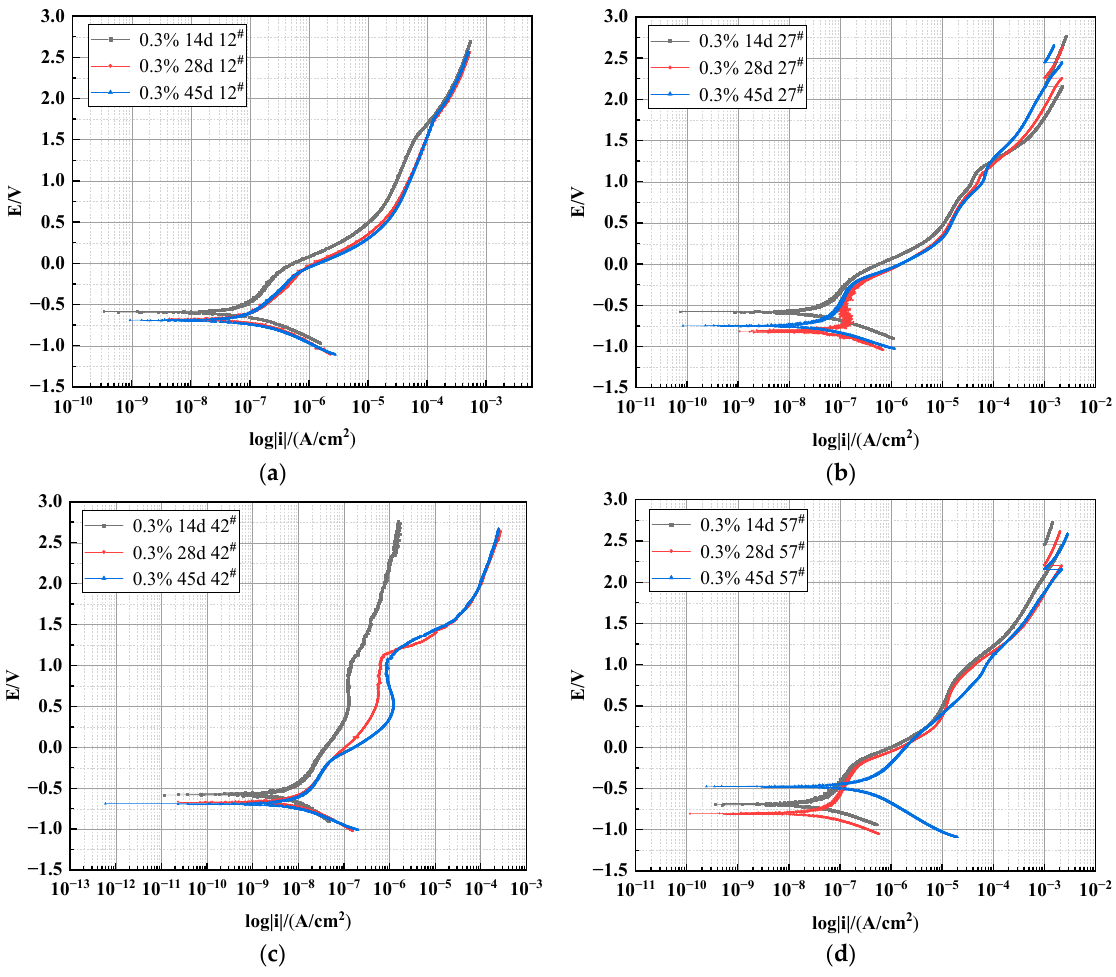
Figure 9. Polarization curves of X70 steel buried in 0.3% NaCl soil column: ( a ) 12 # , ( b ) 27 # , ( c ) 42 # , and ( d ) 57 # . Table 5. Electrochemical corrosion parameters of X70 steel in soil with 0.3% sodium chloride